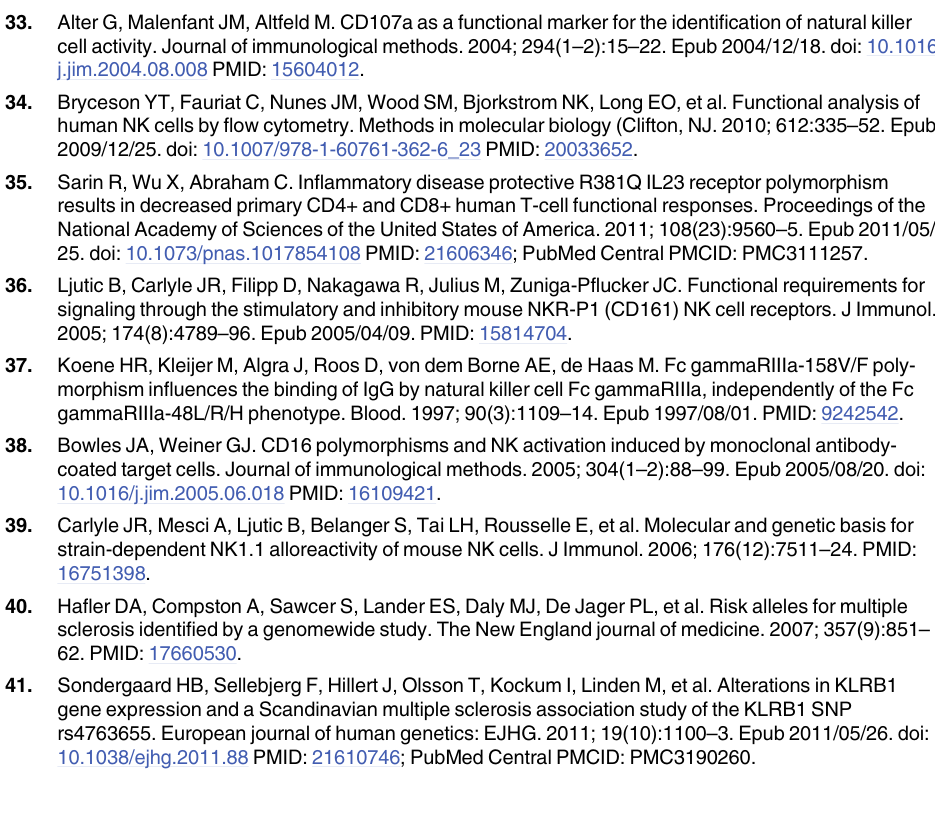
PLOS ONE | DOI:10.1371/journal.pone.0135682 August 26,